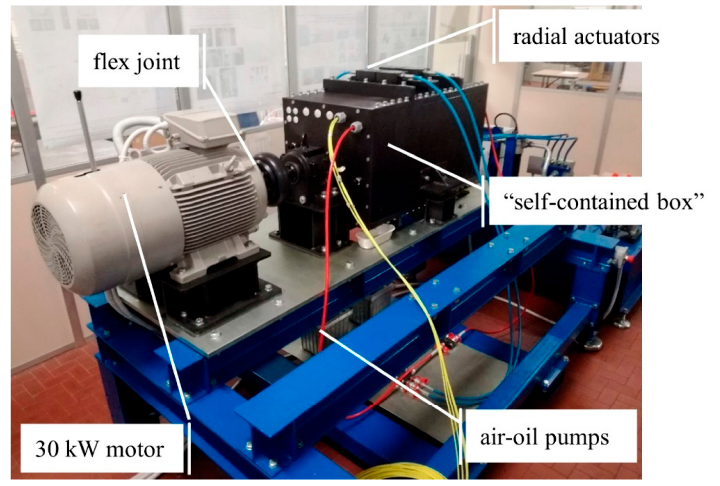
Figure 4. Test rig for industrial bearings [58].